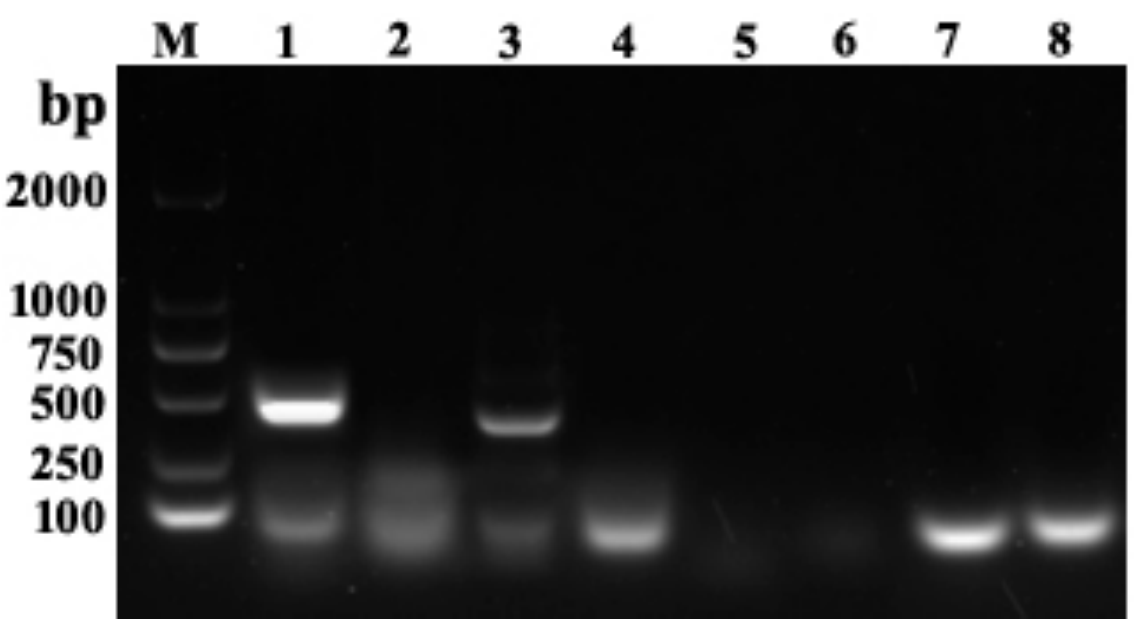
Figure 2. PCR amplicons used for virus detection from tissue homogenates of diseased largemouth bass. (M) A 2000 bp DNA marker, (Lane 1) LMBV detection using the tissue of diseased fish as template, (Lane 2) negative control with water as template, (Lane 3) MSRV detection using the tissue of diseased fish as template, (Lane 4) negative control with water as template, (Lane 5) NNV detection using the tissue of diseased fish as template, (Lane 6) negative control with water as template, (Lane 7) ISKNV detection using the tissue of diseased fish as template, and (Lane 8) negative control with water as template.